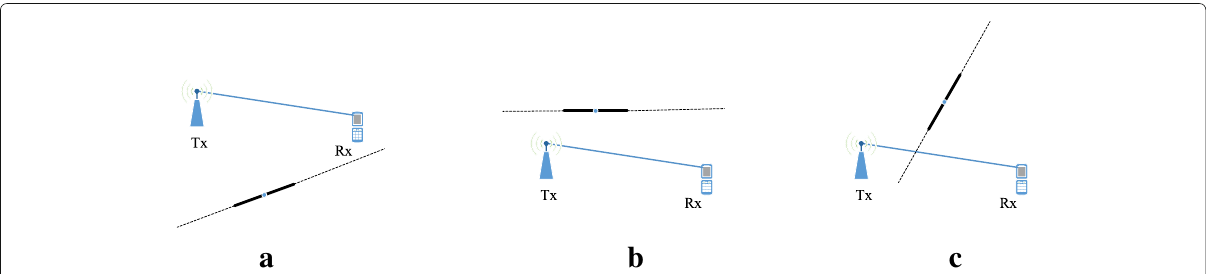
Fig. 4 Illustration of Event 1 based on Approach 4.1.2. Event 1 holds true if both Tx and Rx are above a or below b the infinite line corresponding to the typical object. Event 1 does not hold true if Tx and Rx are not on the same side of the line c